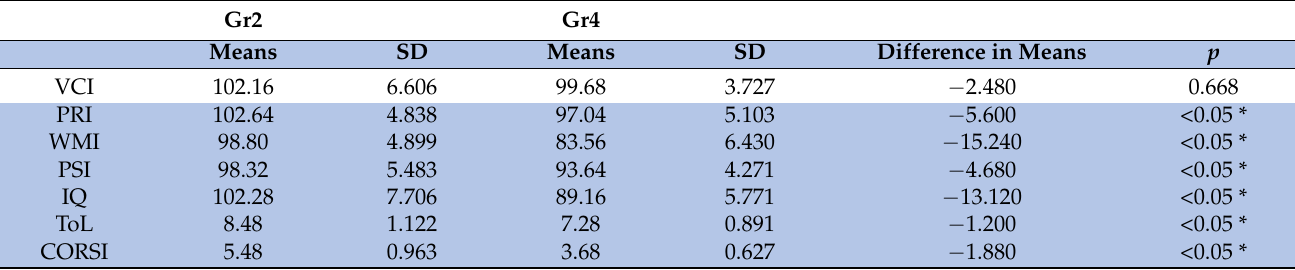
Table 5. Post hoc between Gr2 and